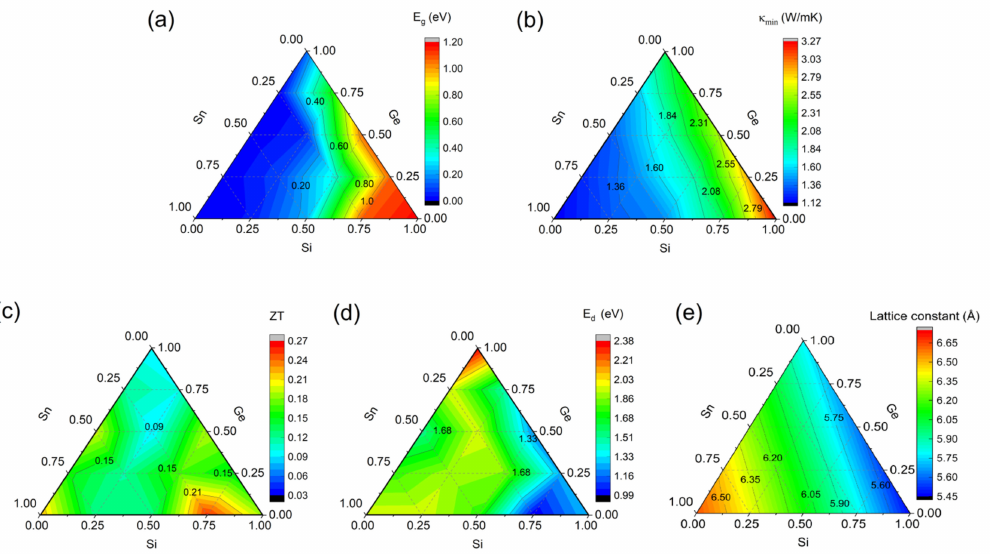
Figure 5. The band gap E g ( a ), lattice thermal conductivity κ min at 800 K ( b ), n-type ZT at 800 K ( c ), band difference E d ( d ), and optimized lattice constant distribution ( e ) of SiGeSn